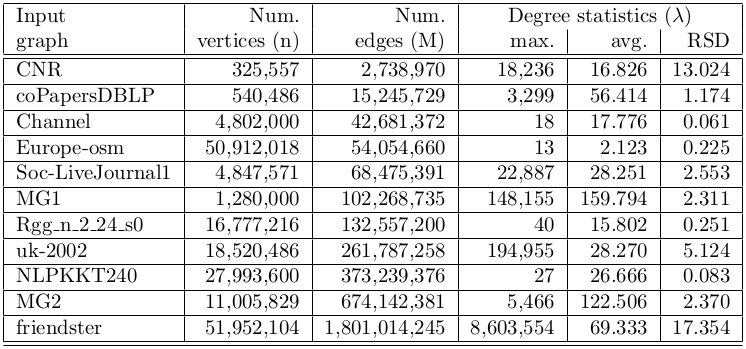
Table from the paper: Parallel Heuristics for Scalable Community Detection
Table text:
Input
Num.
Num.
Degreestatistics(λ)
graph
vertices(n)
edges(M)
max.
avg.
RSD
CNR
325,557
2,738,970
18,236
16.826
13.024
coPapersDBLP
540,486
15,245,729
3,299
56.414
1.174
Channel
4,802,000
42,681,372
18
17.776
0.061
Europe-osm
50,912,018
54,054,660
13
2.123
0.225
Soc-LiveJournal1
4,847,571
68,475,391
22,887
28.251
2.553
MG1
1,280,000
102,268,735
148,155
159.794
2.311
Rggn224s0
16,777,216
132,557,200
40
15.802
0.251
uk-2002
18,520,486
261,787,258
194,955
28.270
5.124
NLPKKT240
27,993,600
373,239,376
27
26.666
0.083
MG2
11,005,829
674,142,381
5,466
122.506
2.370
friendster
51,952,104
1,801,014,245
8,603,554
69.333
17.354